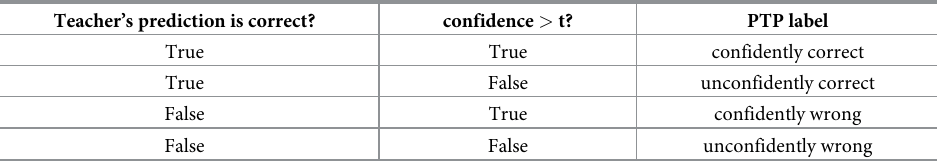
Table 1. Assigning new PTP labels to the training